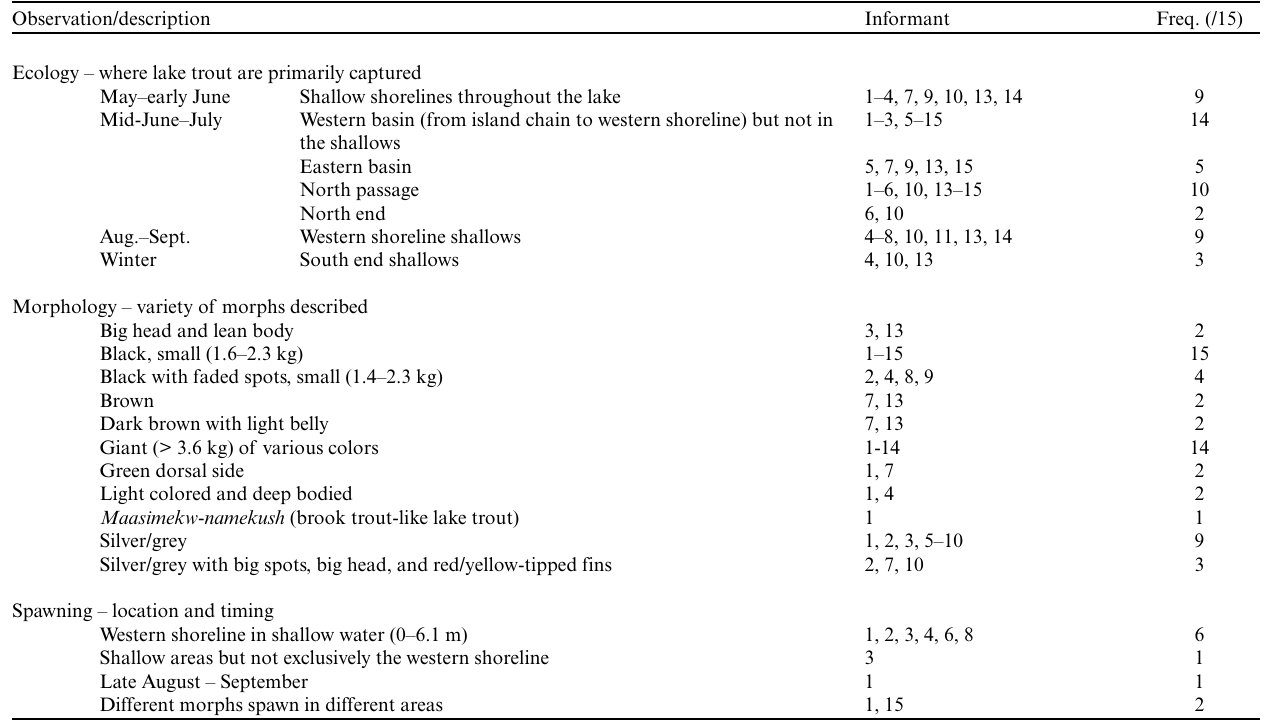
Table 2 . Overall ecological and morphological diversity of lake trout in Mistassini Lake as described by local experts. Observation/description Informant Freq. (/15)